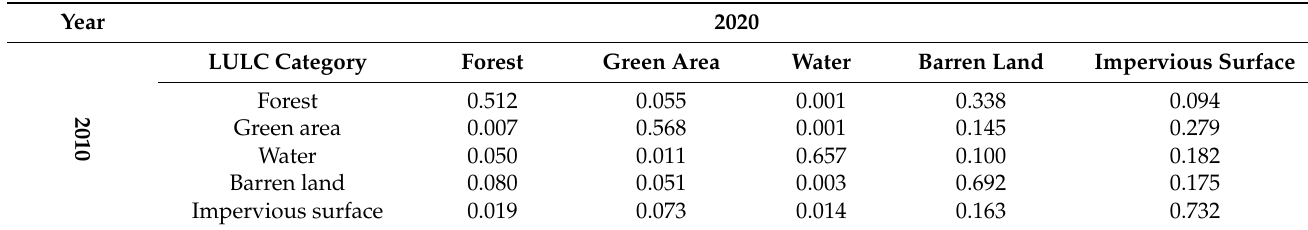
Table 8. Transition matrix from 2010–2020.